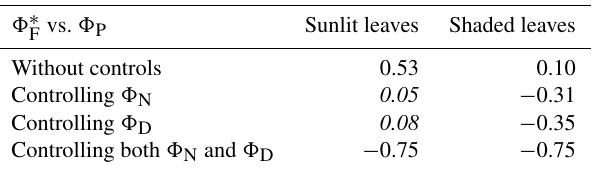
Table 2. Correlation coefficients (the first row) and partial cor- relation coefficients (i.e., controlling for or eliminating sepa- rate effects) between fluorescence and photosynthesis. The coef- ficients are placed in italics if the relationship is not significant ( p value > 0.10).